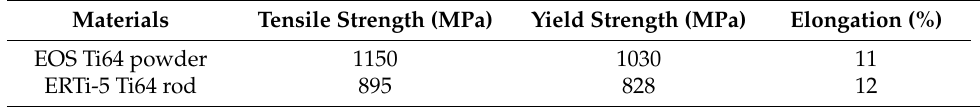
Table 2. Mechanical properties of the used materials.